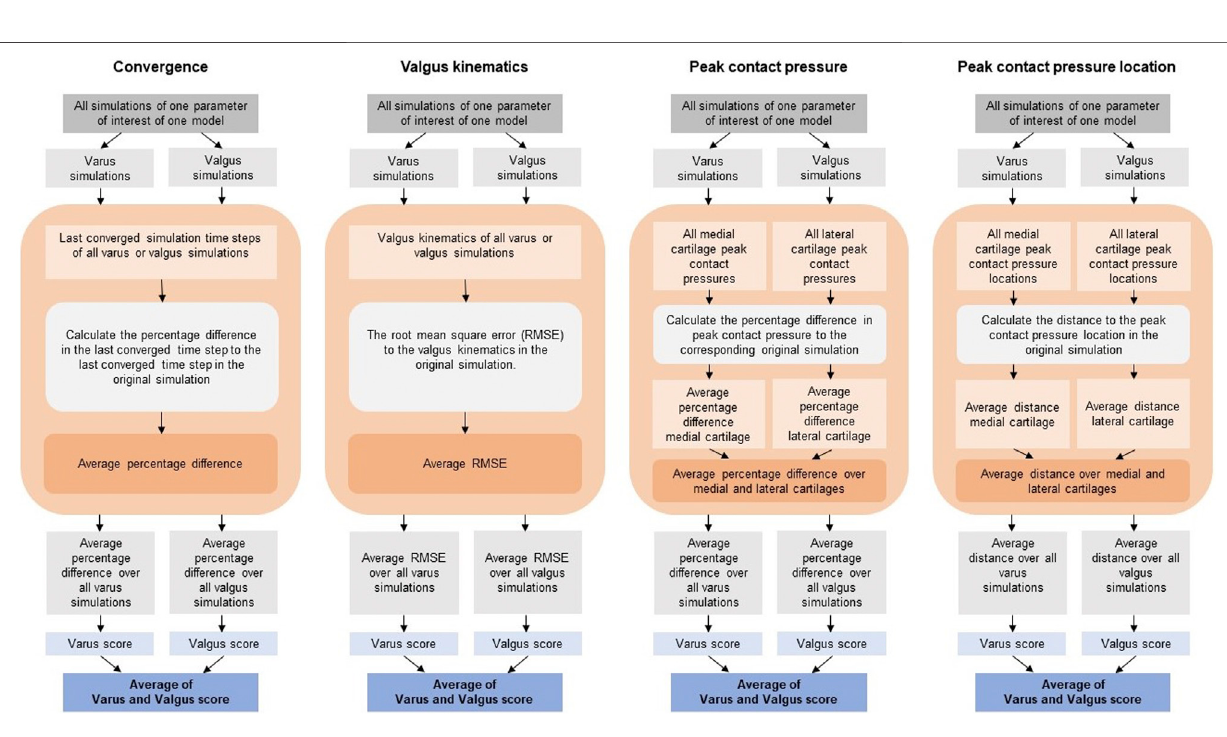
FIGURE 3 | Analysis work fl ows of the four outcome